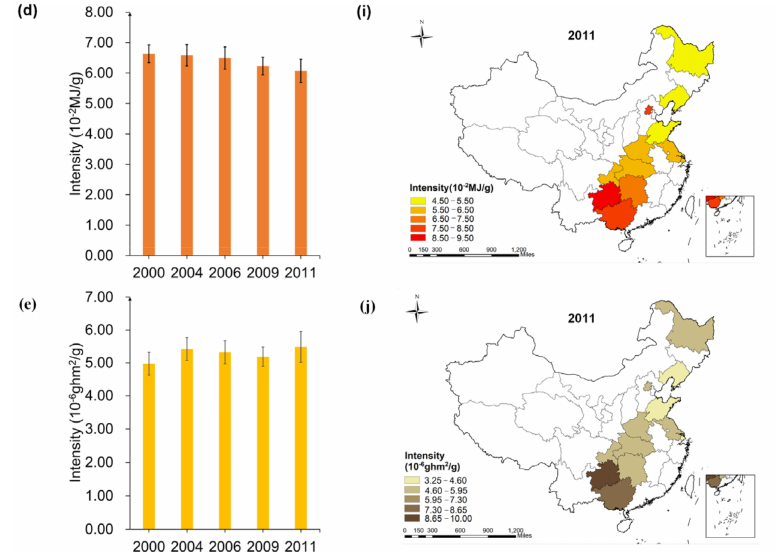
Figure 5. Spatial-temporal characteristics of multiple footprint intensity of protein intake (( a , f ): WF; ( b , g ): CF; ( c , h ): NF; ( d , i ): EF; ( e , j ): LF; The error lines in the figure are standard errors). The multiple footprints intensity of nutrient intake of household in Guizhou was the highest in 2011, reached 3.99 × 10 − 2 m 3 /g ( WFI ), 2.36 × 10 − 2 kg CO eq/g ( CFI ), p 2 p 5.91 × 10 − 4 g/g ( NFI ), 8.74 × 10 − 2 MJ/g ( EFI ) and 9.68 × 10 − 6 ghm 2 /g ( LFI ), respec- p p p tively. The WFI p , CFI p , EFI p and LFI p of households in Shandong were the lowest, which was 2.12 × 10 − 2 m 3 /g, 1.307 × 10 − 2 kg CO eq/g, 4.82 × 10 − 2 MJ/g and 4.22 × 10 − 6 ghm 2 /g, 2 respectively. The NFI p of household in Beijing was the lowest, which was 3.50 × 10 − 4 g/g.